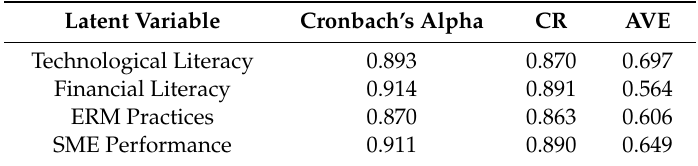
Table 3. Internal consistency reliability and convergent validity. CR—composite reliability; AVE—average variance